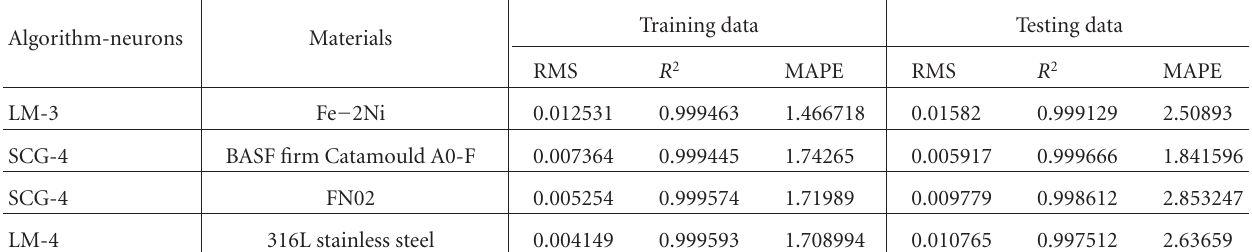
Table 8: Statistical error values.